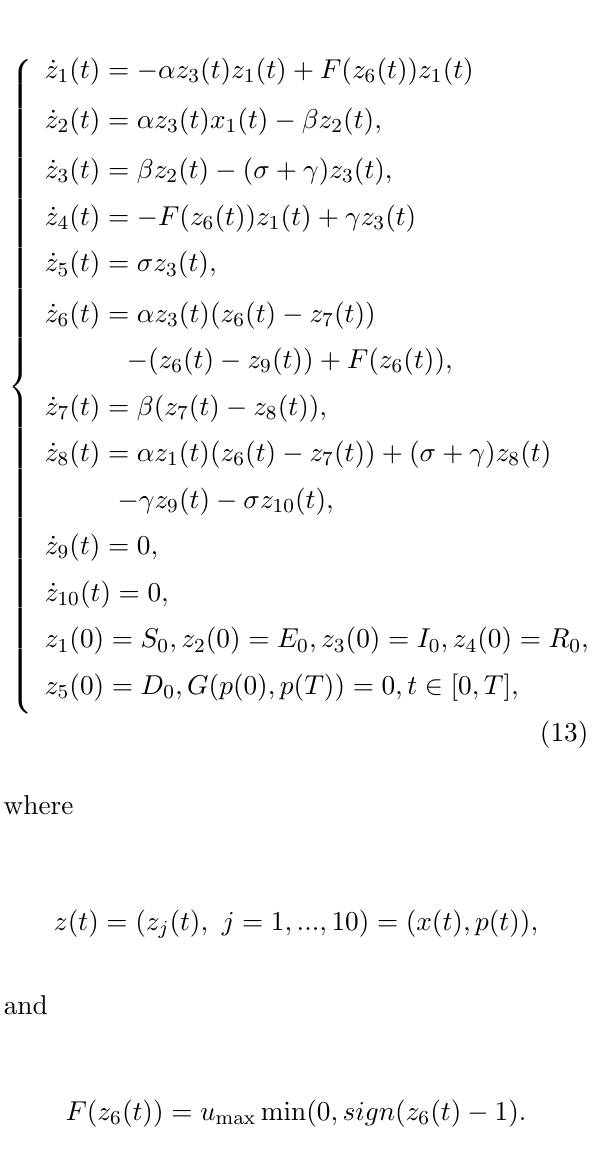
Figure 2. Evolution of stats after 70 days with vaccine.